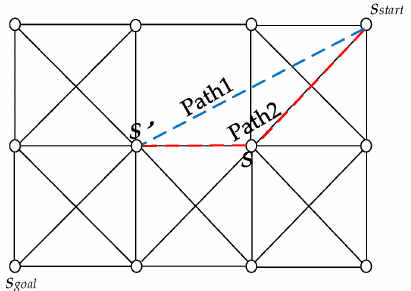
Figure 12. A* Algorithm and Theta* Algorithmic Planning Path